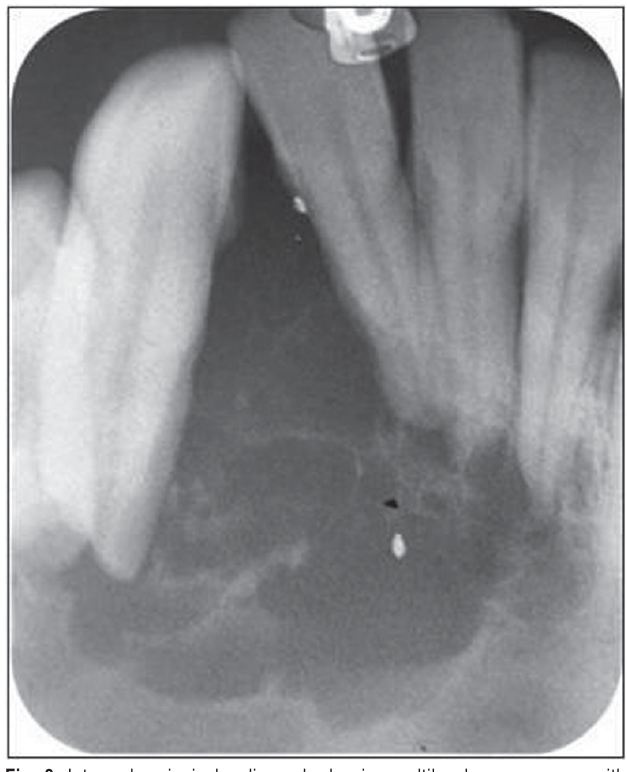
Fig. 8. Intraoral periapical radiograph showing multilocular appearance with divergence of the roots.